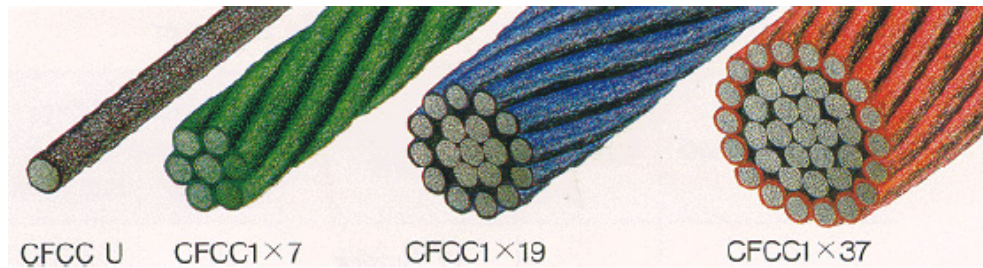
Figure 6. Types of carbon fiber composite cable strands used in the pre-stressing of concrete structures [78].